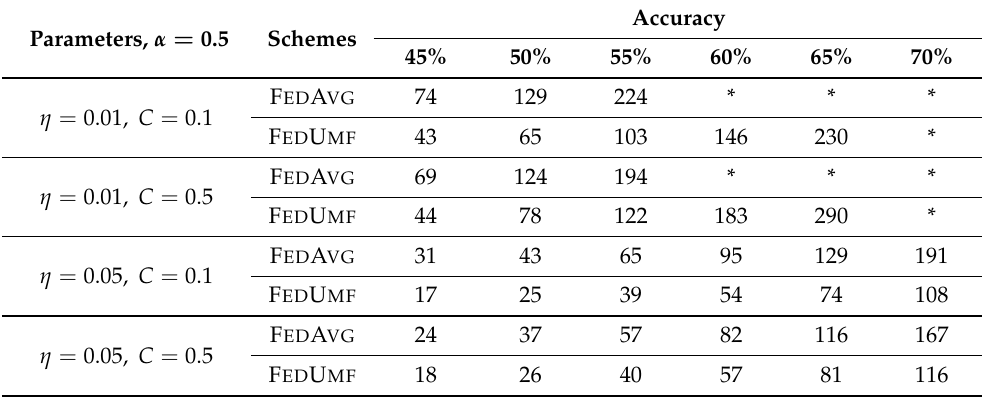
Table 4. Accuracy on CIFAR10 dataset, non-IID partition. Parameters, α =